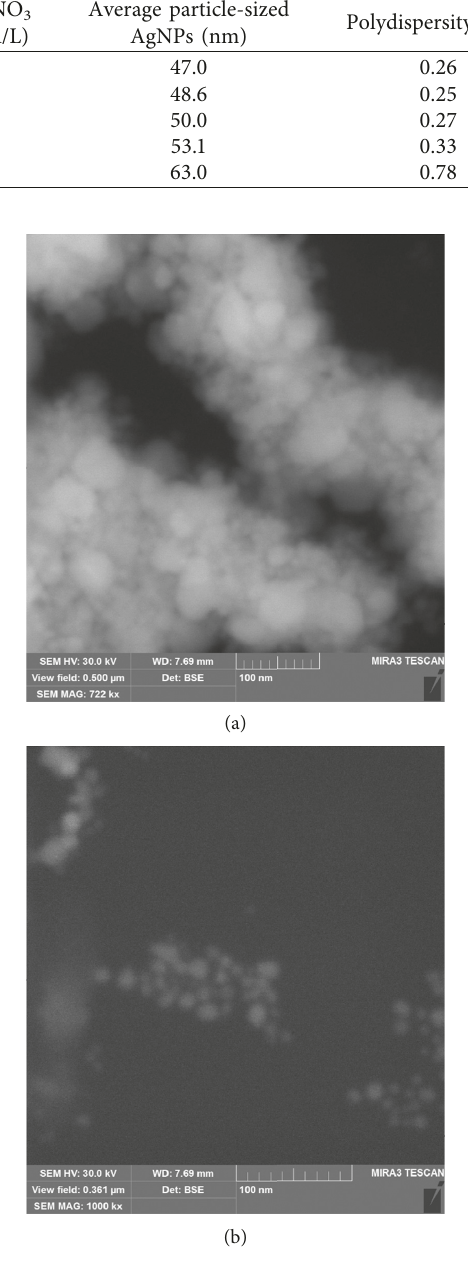
Figure 5: SEM images of obtained silver nanoparticles ( S (Ag + ) � 1.0 mmol/L, τ � 10min, and ratio AgNO 3 : extract (mL) �